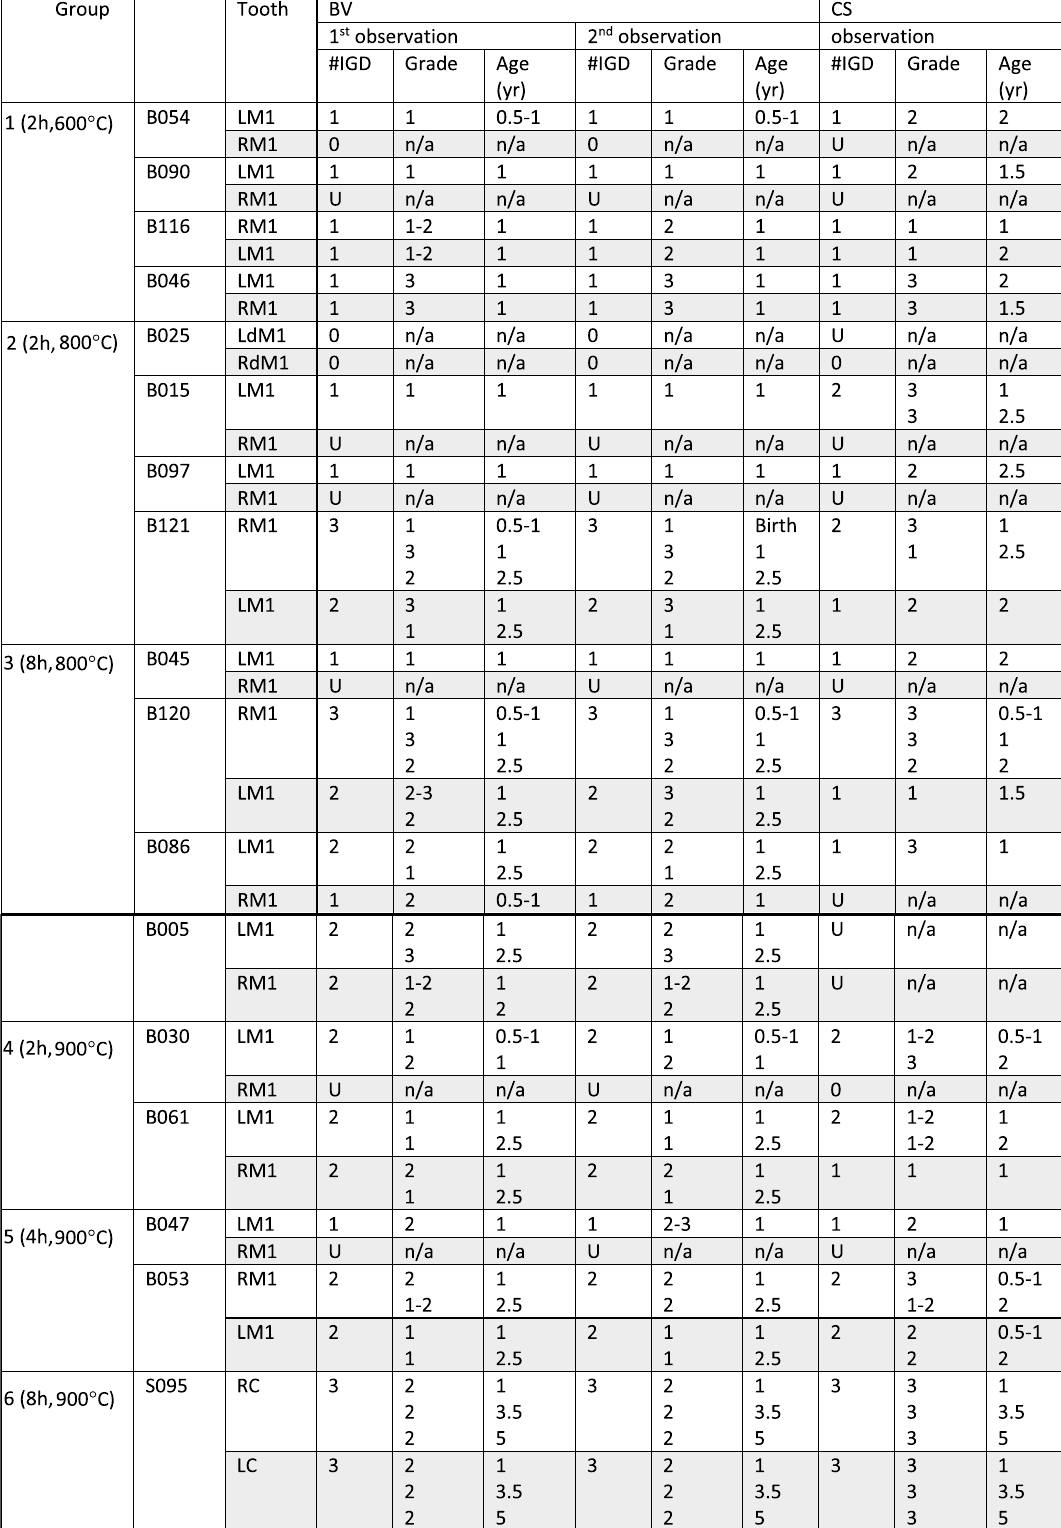
Table 1. IGD occurrence per tooth noted for the 1st and 2nd observation of BV and the observation of CS per group. The grey boxes represent the burnt teeth. LM1 = left permanent first molar, RM1 = right